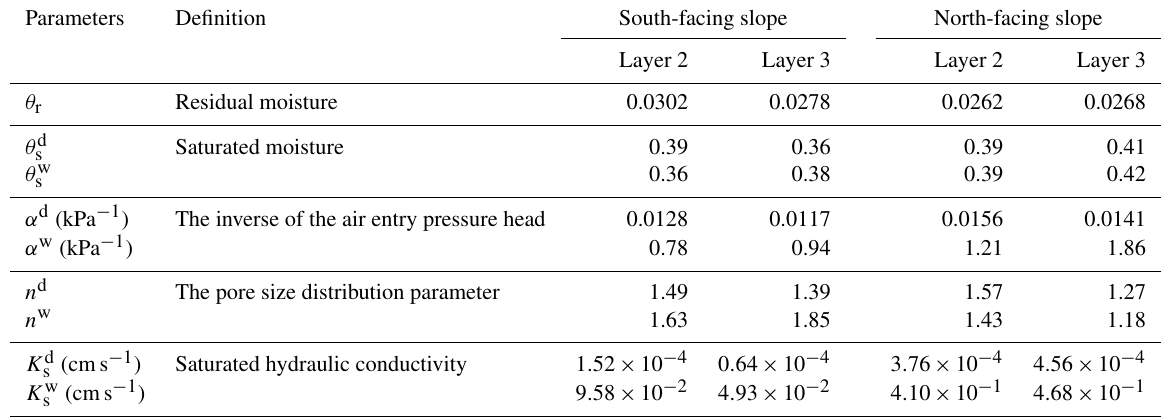
Table 2. Parameters describing the soil and water characteristic curve (SWCC) and the hydraulic conductivity function (HCF) from Hy- drus 1D.